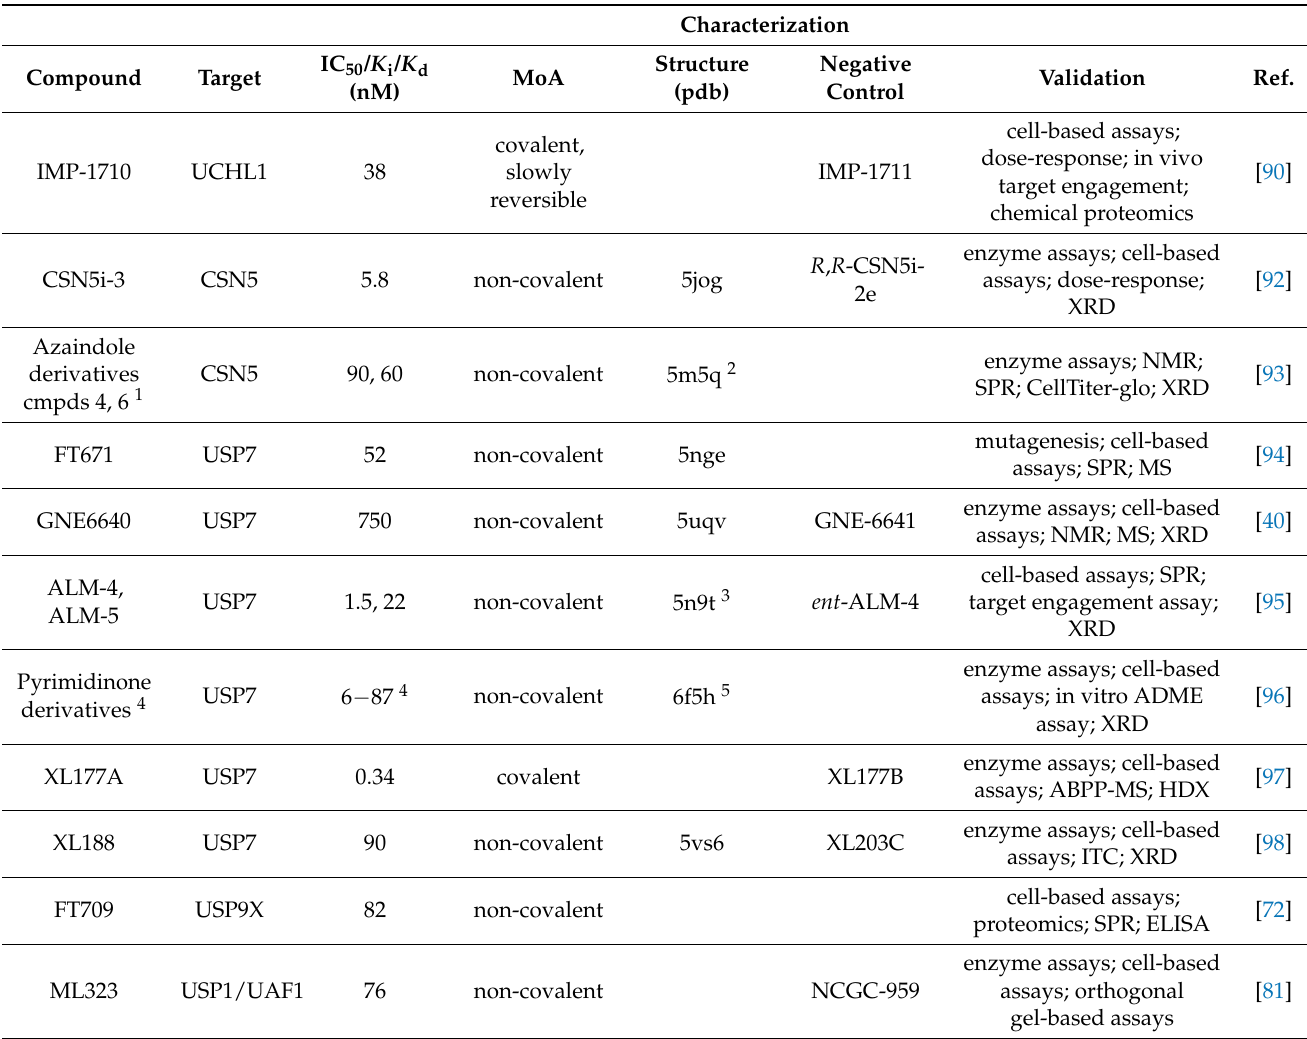
Table 1. Potent small molecule DUB inhibitors.